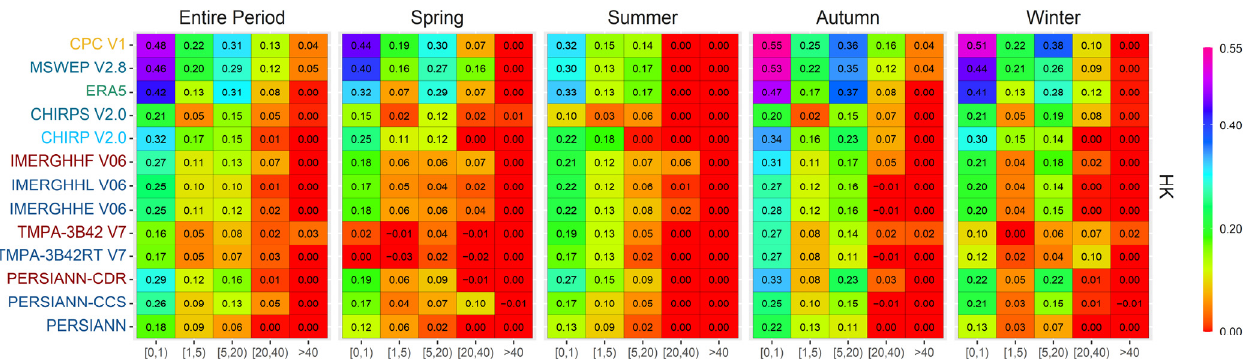
Figure 8. GPD detection ability in reproducing daily precipitation intensities expressed in the form of the Hanssen–Kuiper (HK) score considering the entire period and four seasons. Y-axis color presents: satellite-based (blue), gauge and satellite (red), reanalysis and satellite (sky blue), reanalysis (green), reanalysis, ground, and satellite (steel blue), and ground (yellow).